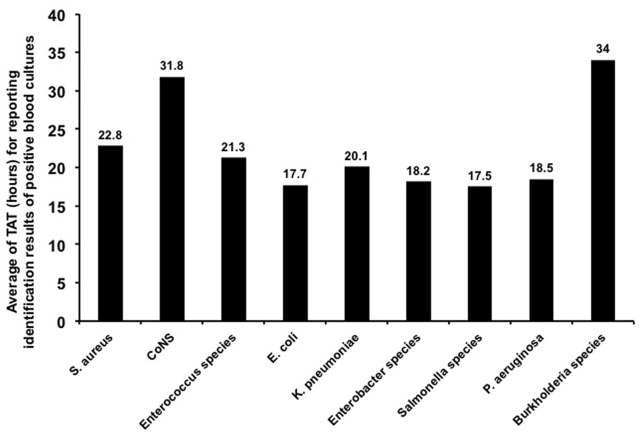
Turn-around time (TAT) of positive blood cultures. TAT of blood cultures for several main microorganisms (no. of isolates ≥5) from positive blood cultures with concordant identification results of ≥90% with conventional phenotypic methods. TAT of blood cultures was defined as the time interval between blood cultures collected from patients and laboratory reporting of identification results from positive blood cultures.